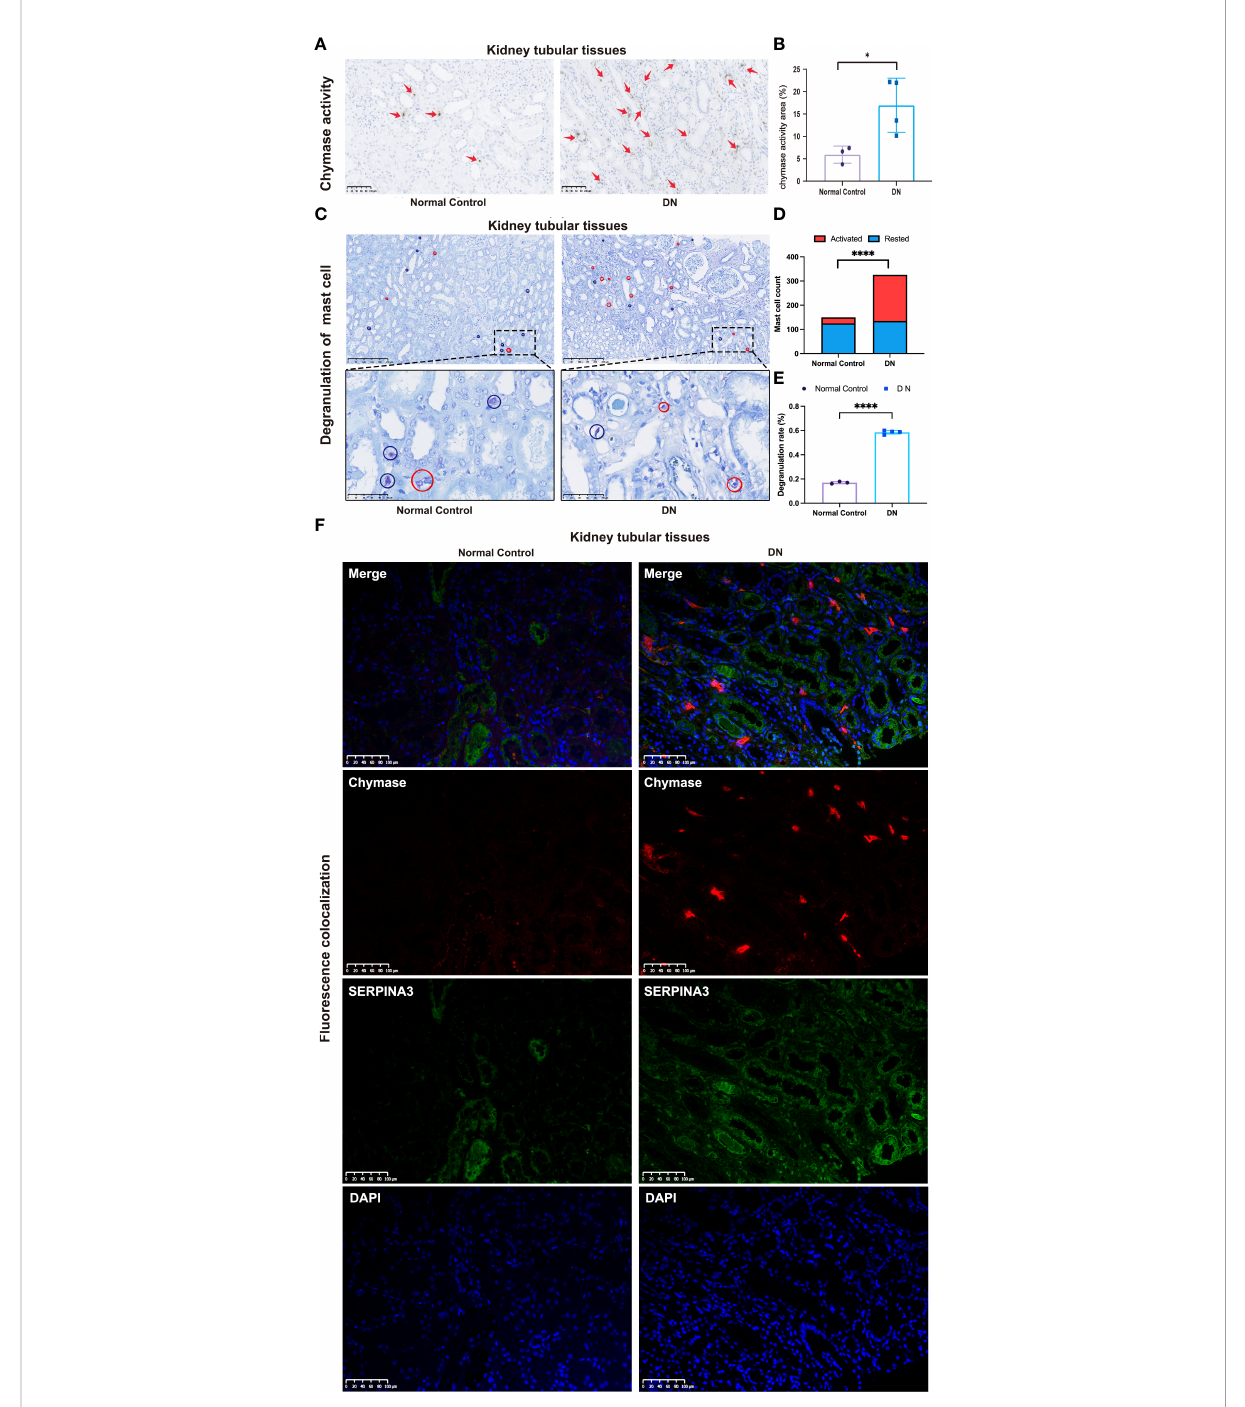
FIGURE 8 Correlation between SERPINA3 expression levels and chymase activity in mast cells. (A) Images of immunohistochemical staining for chymase activity in kidney tubular tissue samples from patients with DN and healthy controls. Scale bars = 100 µm. (B) Semi-quantitative analyses of the chymase activity area. (C) Observation of mast cell degranulation in the renal tubular tissue of patients with DN and healthy controls by toluidine blue staining. Red circles indicate cells in a degranulated state, while blue circles indicate cells in a resting state. Scale bars = 250 µm (images above) and scale bars = 50 µm (images below). Microscopes were used at magni fi cations of 100× and 500×, respectively. (D) Histogram of the number of activated and resting mast cells in the DN and control groups. (E) Proportion of mast cell degranulation observed in patients with DN and healthy controls determined by toluidine blue staining. Data shown are the mean ± SEM (n = 4). (F) Colocalization of SERPINA3 (green) and chymase (red) in tubule tissue. *P < 0.05 and ****P <